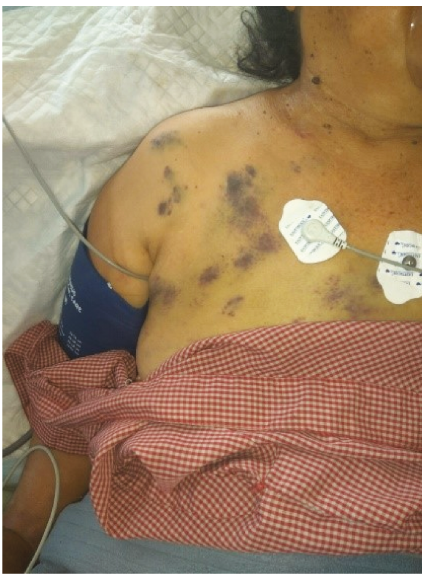
Figure 1: Purpuric rashes developed on the anterior chest and anterior abdomen after the patient was admitted.